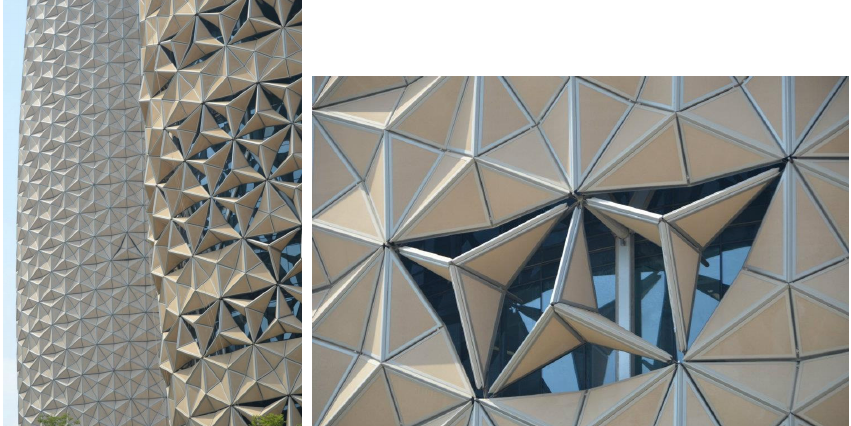
Figure 14. Al Bahar Towers, Abu Dhabi—Aedes (Courtesy Terri Boake, University of